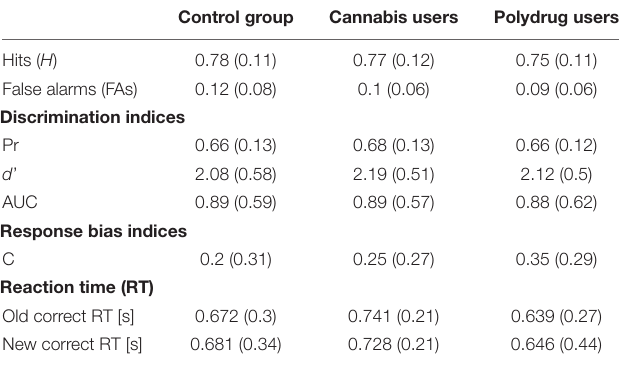
TABLE 3 | Recognition memory performance – mean